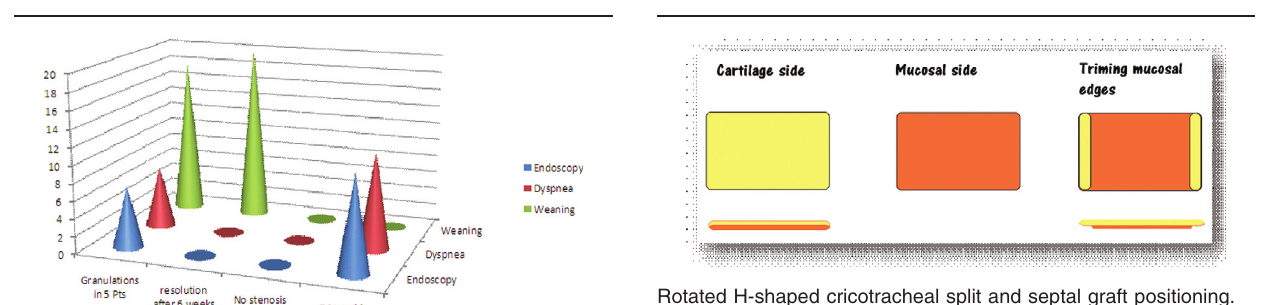
Rotated H-shaped cricotracheal split and septal graft